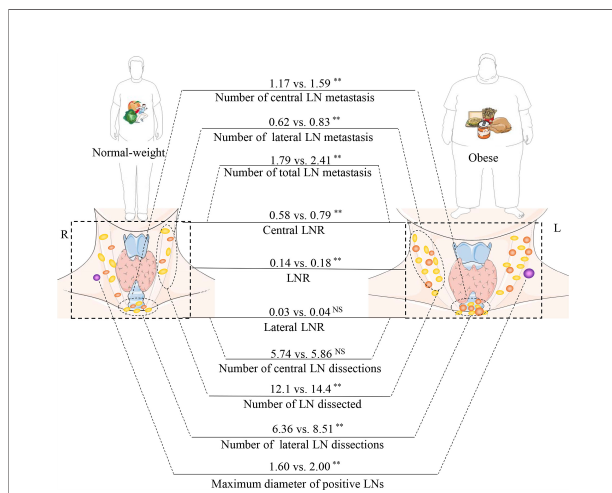
FIGURE 3 | Relationship between obesity and the rules of lymph node (LN) metastasis. The part of schematic art pieces used in this fi gure were provided by Servier Medical art (http://servier.com/Powerpoint-image-bank). Servier Medical Art by Servier is licensed under a Creative Commons Attribution